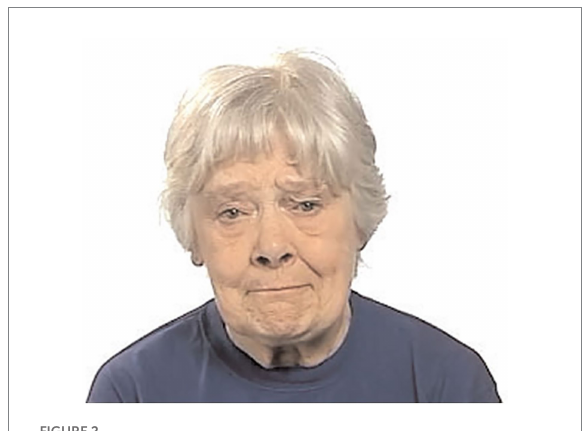
FIGURE 2 Picture stimuli for target word worried_2. Reproduced with permission from The Autism Research Centre, The University of Cambridge; see footnote